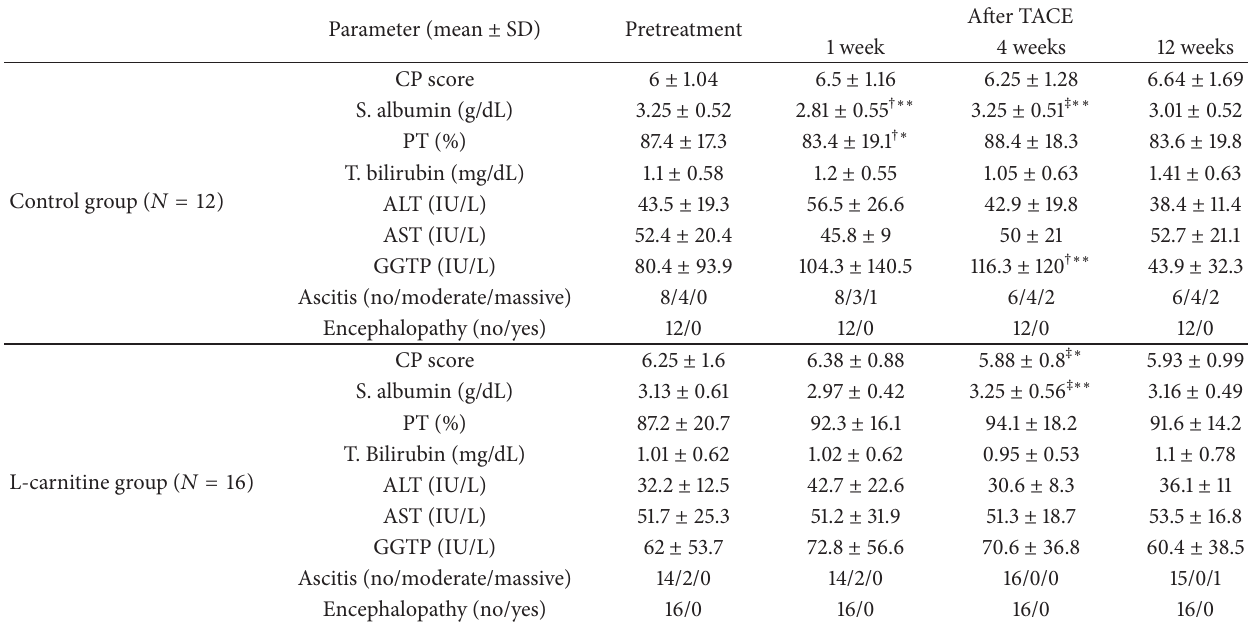
Table 3: Effects of L-carnitine in BCAA+